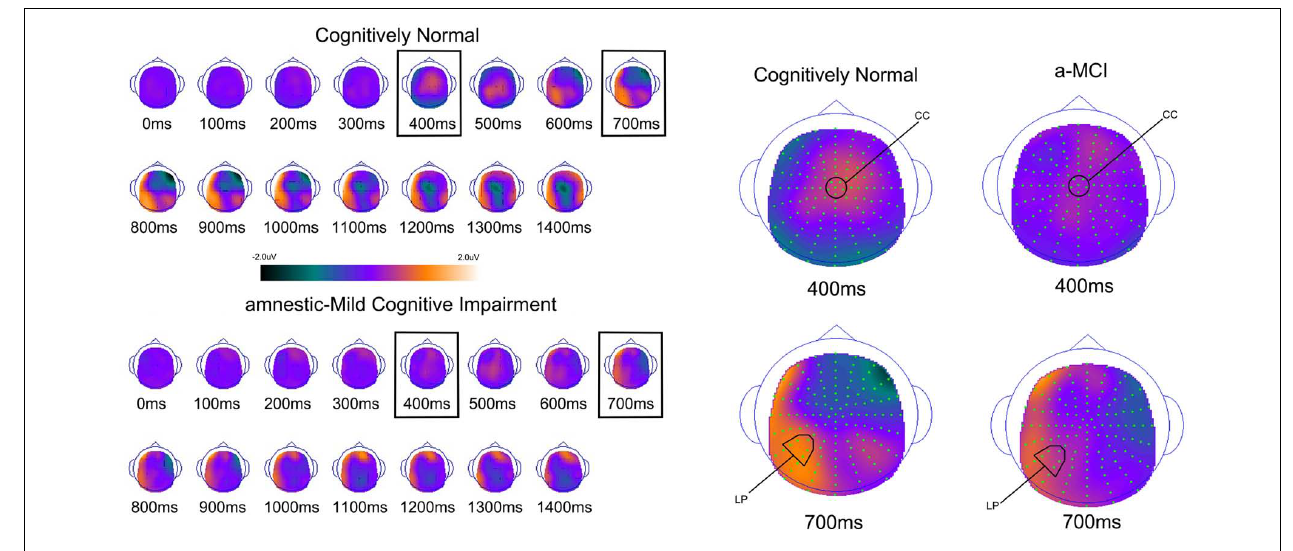
FIGURE 5 | Scalp topography maps for CN adults and patients with amnestic mild cognitive impairment for retrieval attempt effects (studied minus unstudied words) matched for performance. Highlighted